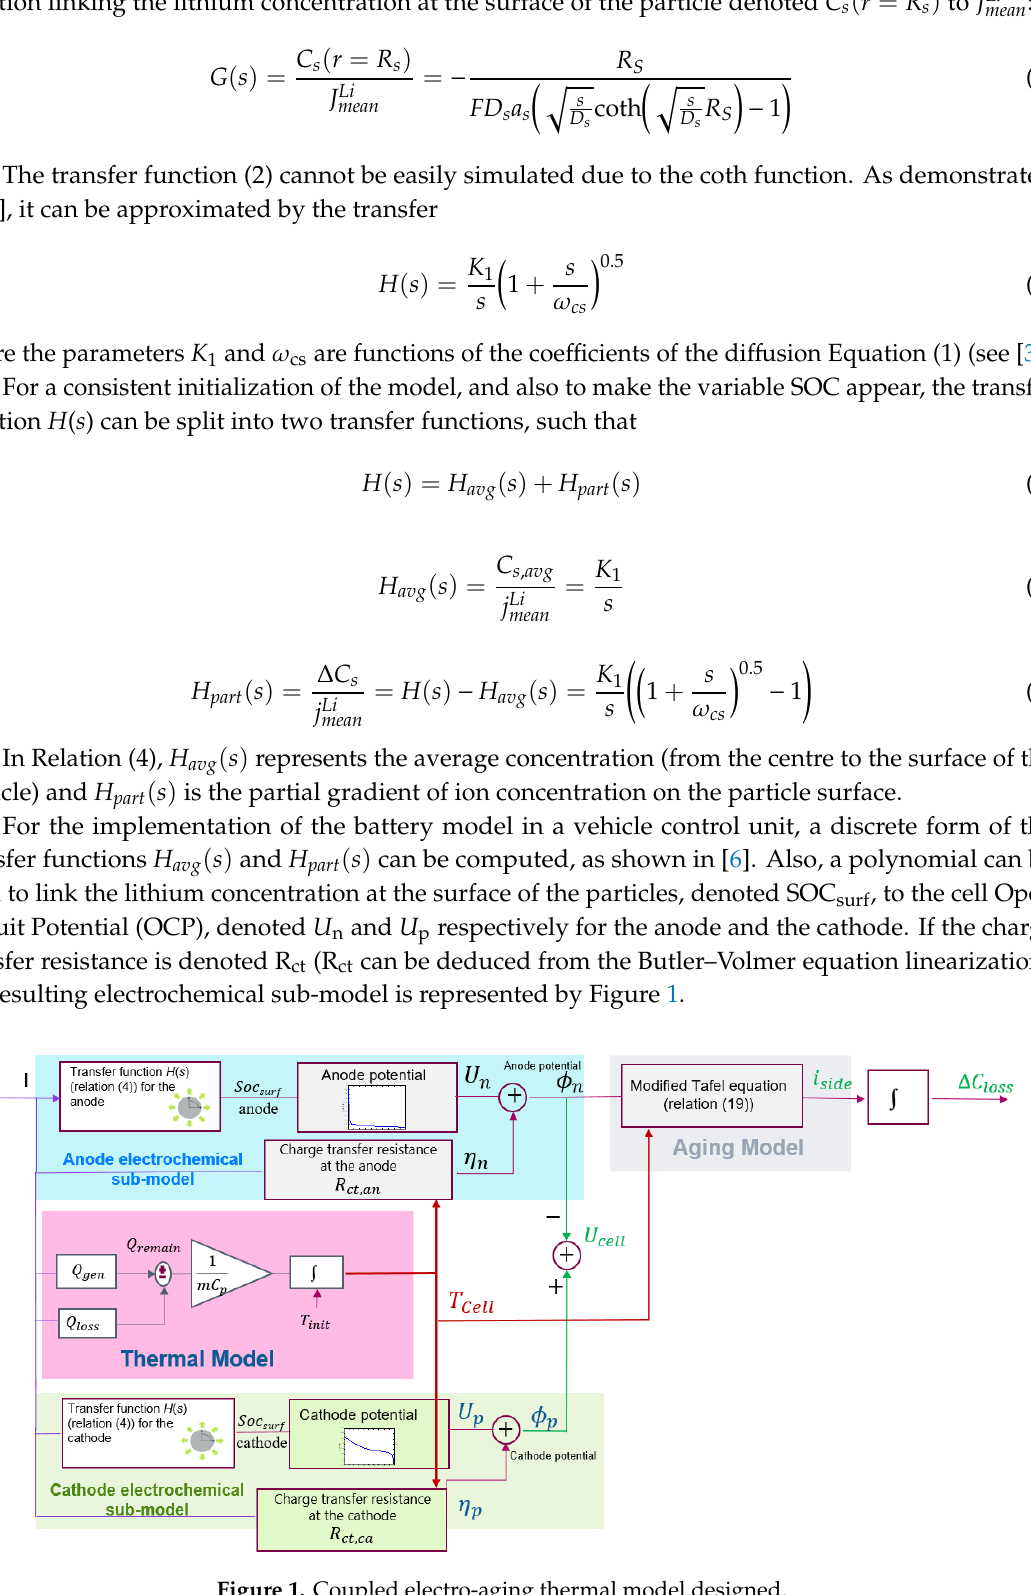
Figure 1. Coupled electro-aging thermal model designed.